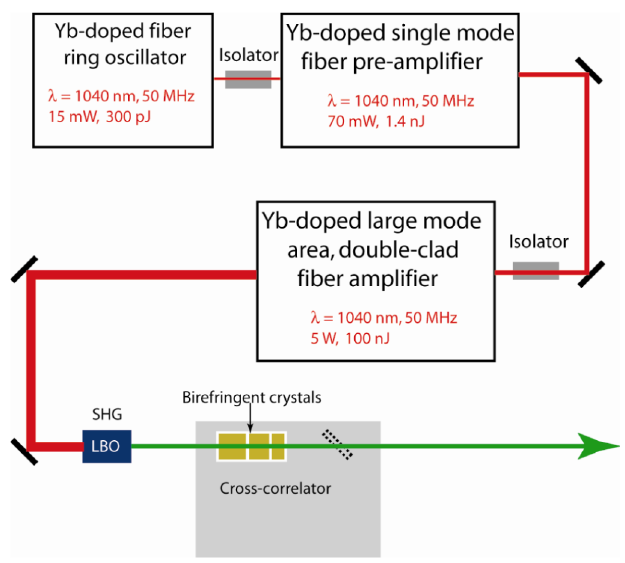
FIG. 2. (Color) Schematic of the laser